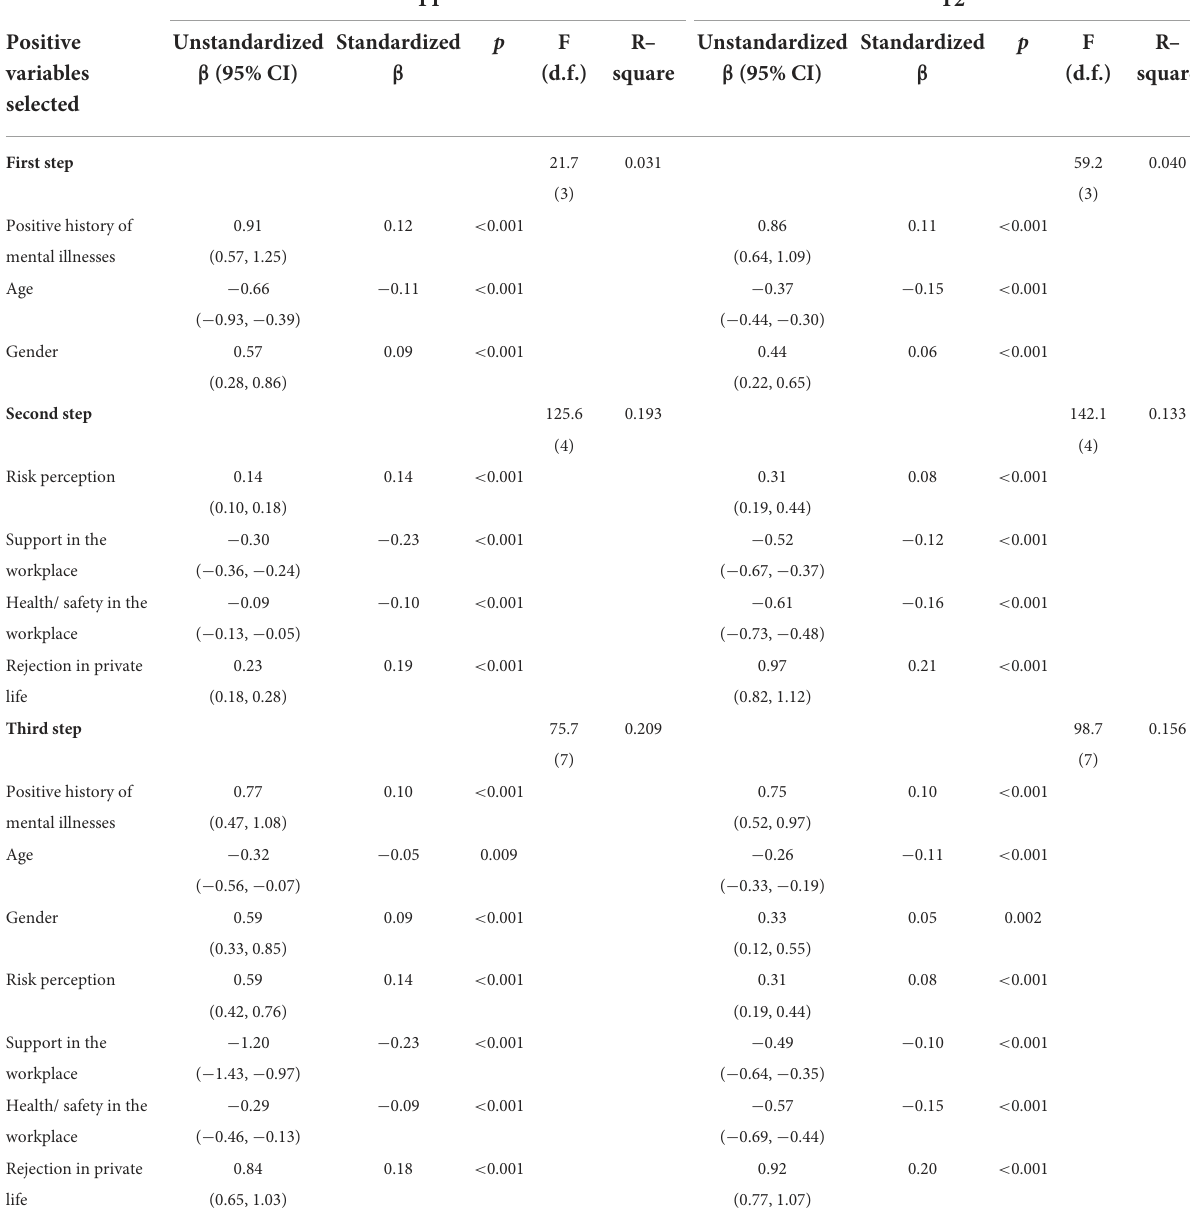
TABLE 3 Predictive variables of the sum scores of PSS-4 in the hierarchical linear regression model at T1 ( n = 2,110) and T2 ( n = 3,745).